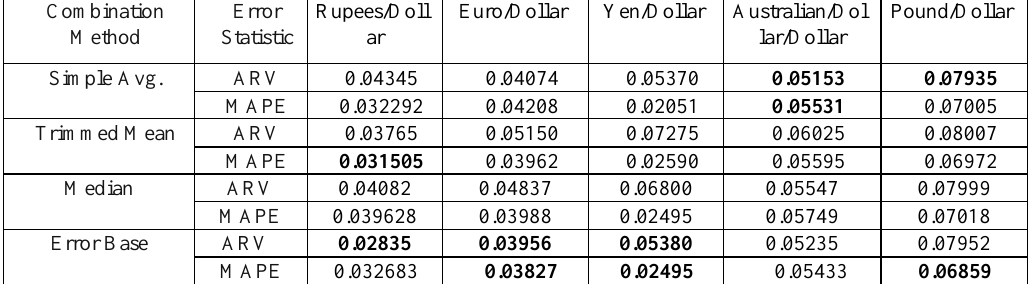
Table 6 . Performance of ensemble methods on five exchange rate series